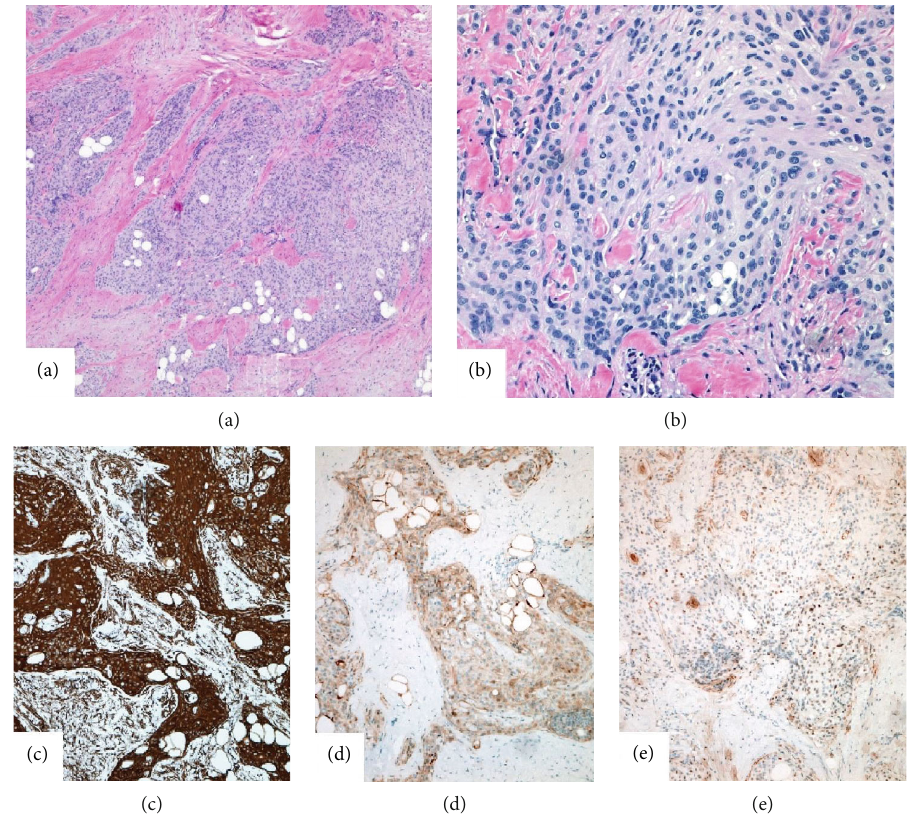
Figure 2: (a) Cords and nests of tumor cells are surrounded by dense fi brotic stroma and adipose tissue; hematoxylin-eosin, original magni fi cation × 40. (b) The meningothelial cells are spindly looking with pink cytoplasm. Cells are packed together forming syncytial structures and whorls; hematoxylin-eosin, original magni fi cation × 200. (c) Tumor cells show strong and di ff use cytoplasmic staining with vimentin (magni fi cation × 100), (d) weak to moderate cytoplasmic and nuclear staining with S-100 (magni fi cation × 100), and (e) focal weak to moderate nuclear staining with progesterone receptor (PR) (magni fi cation × 100).